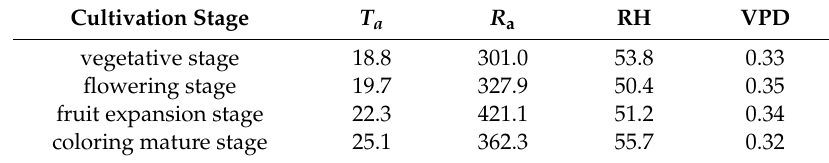
Table 1. Meteorological data of di ff erent cultivation stages during the growing season.